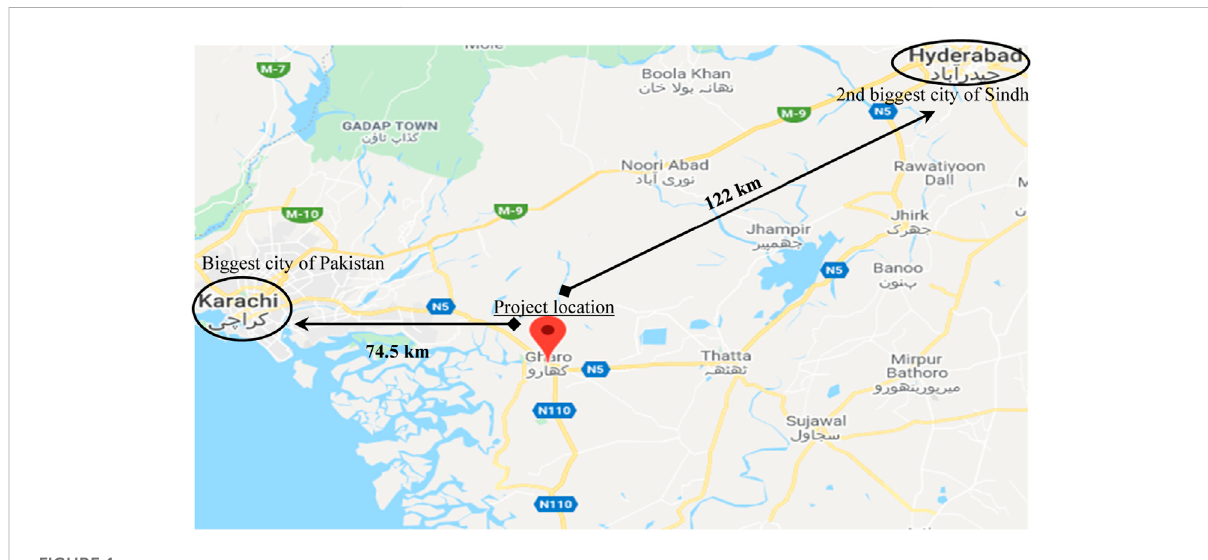
FIGURE 1 Wind farm location map.